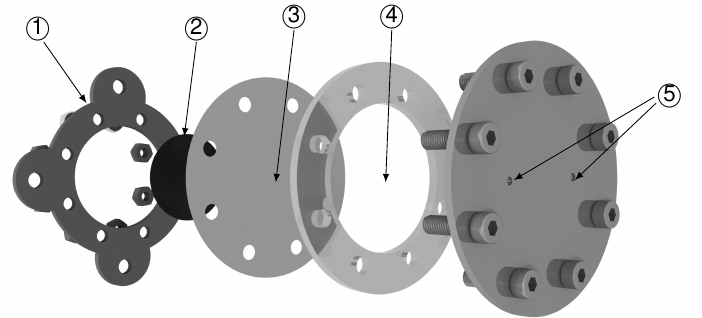
Figure 1. Exploded view of the double-orifice synthetic actuator, with indication of the main connection elements: support (1), piezo-element (2), shim (3), cylindrical cavity (4), orifices